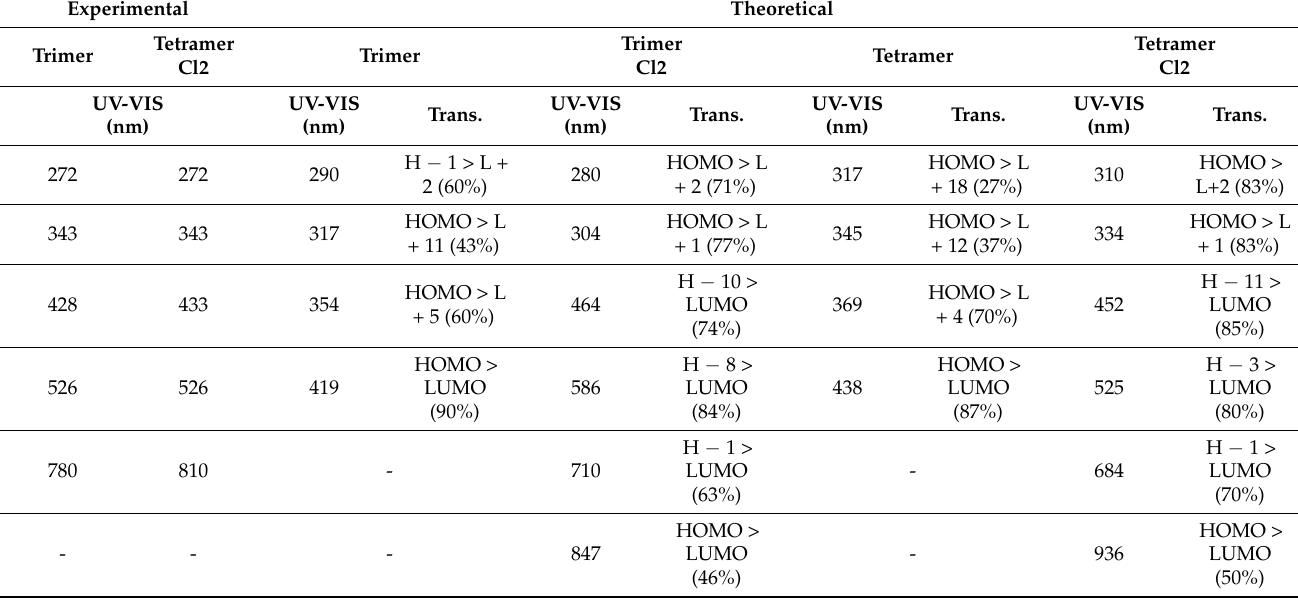
Table 4. Wavelengths and electronic transitions of experimental and theoretical